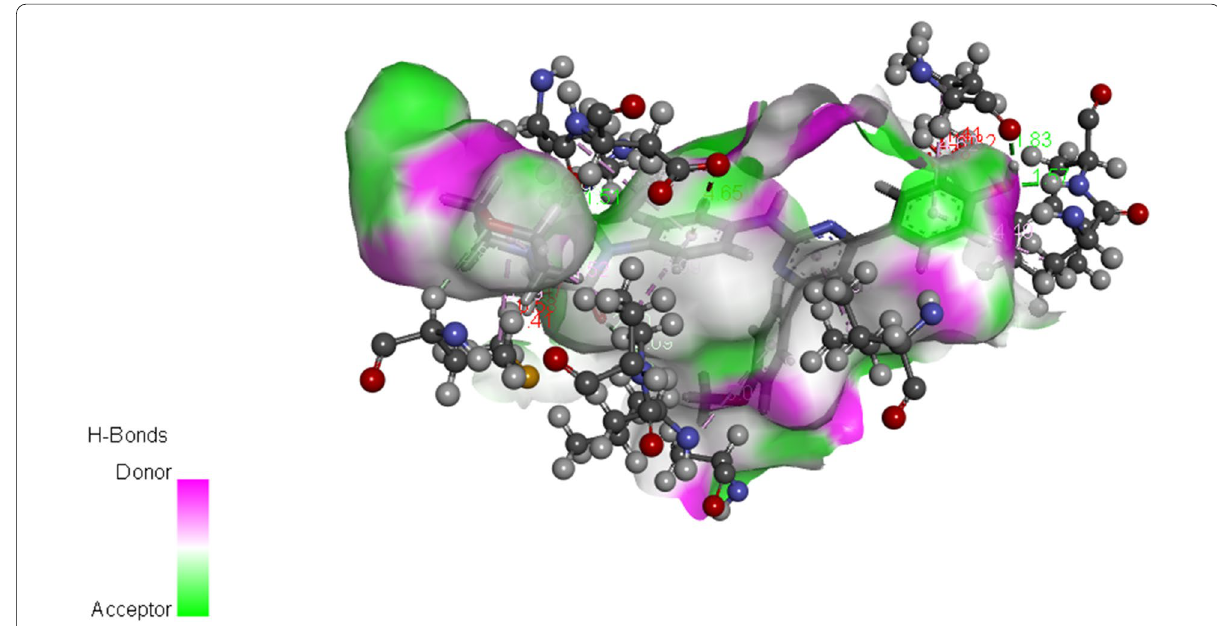
Fig. 7 3D structure of the template interactions with VEGFR-2 receptor